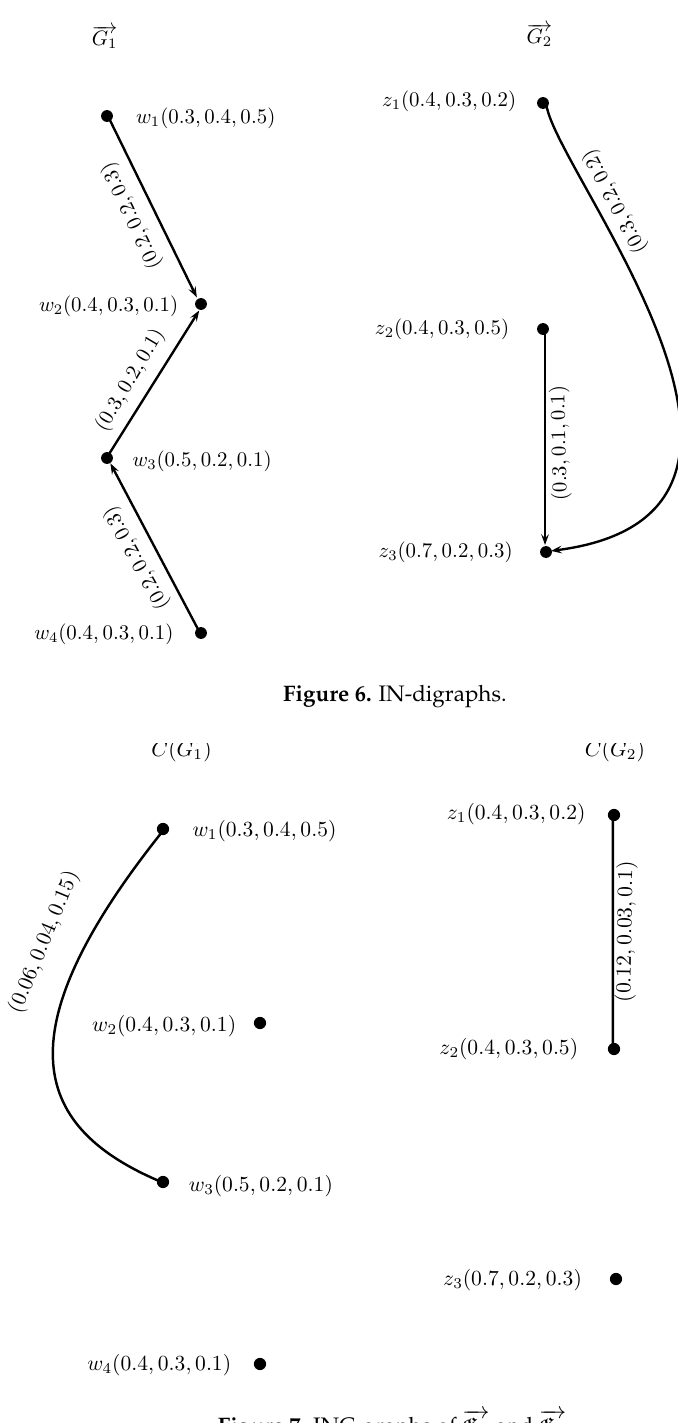
Figure 7. INC-graphs of −→ G 1 and −→ G 2